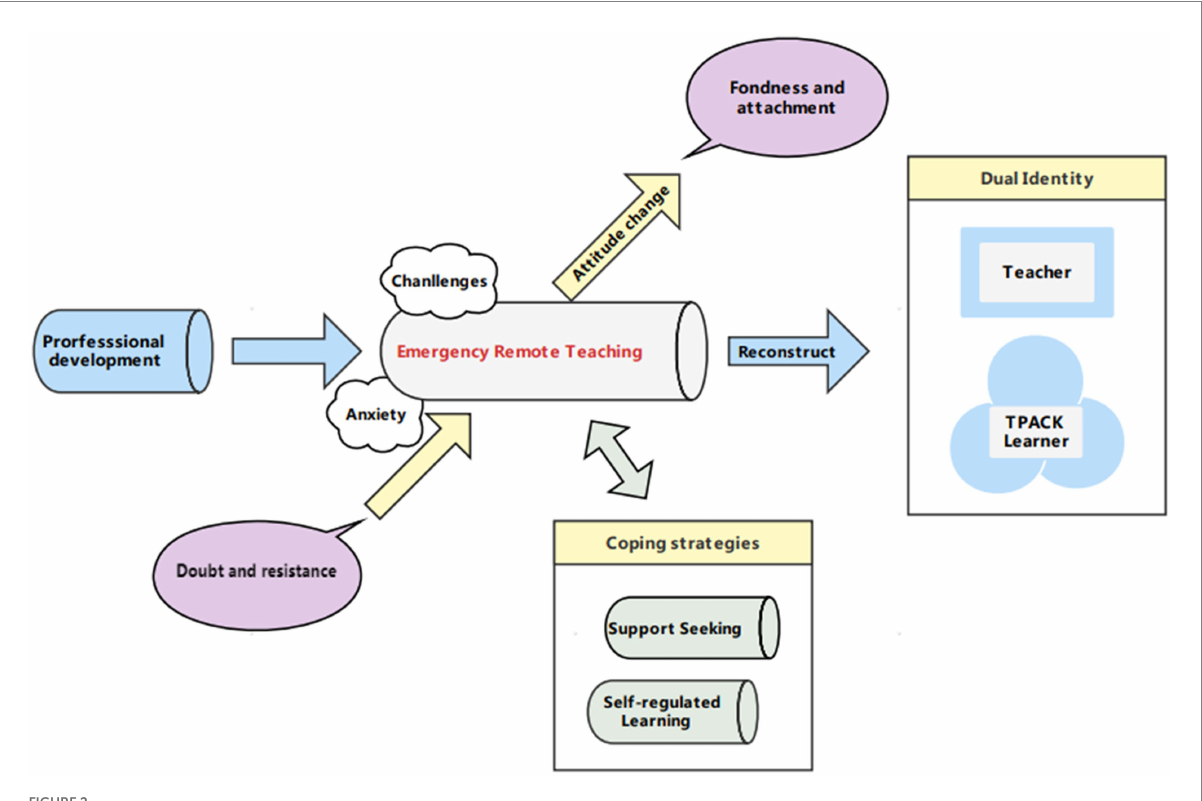
FIGURE 2 A systematization of teachers’ perception in